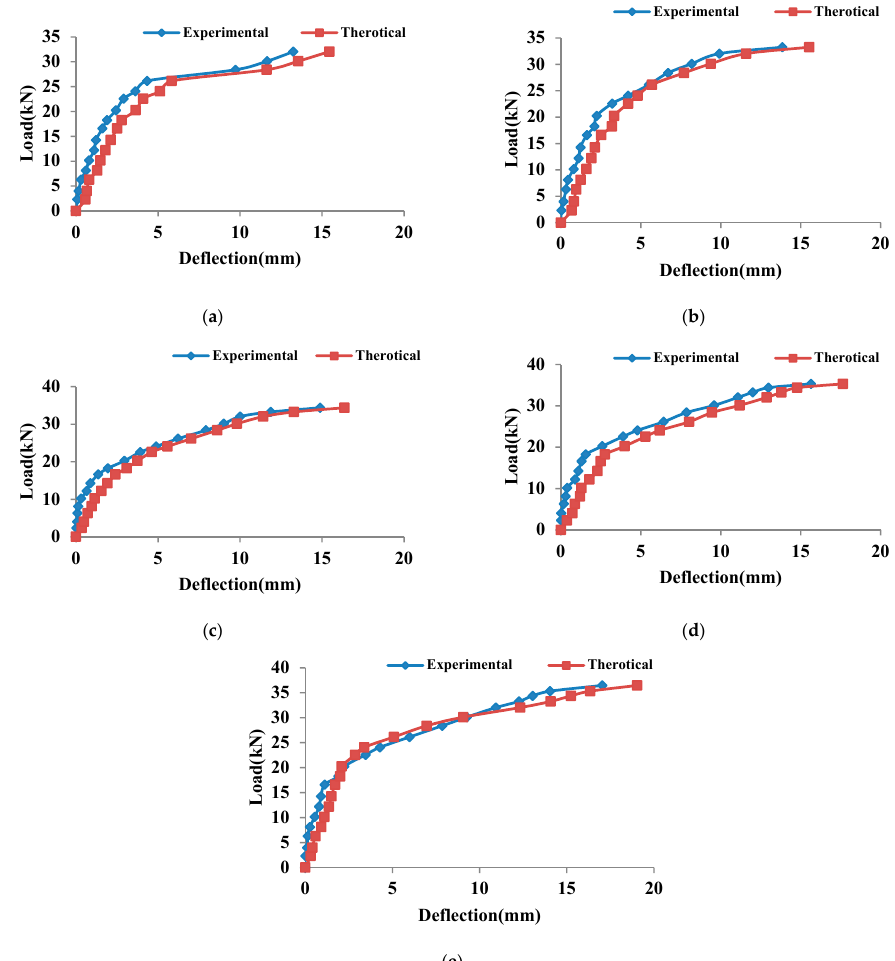
Figure 10. The comparison of the experimental and predicted deflection of ( a ) CS, ( b ) CSF25, ( c ) CSF50, ( d ) CSF50, and ( e ) CSF100.